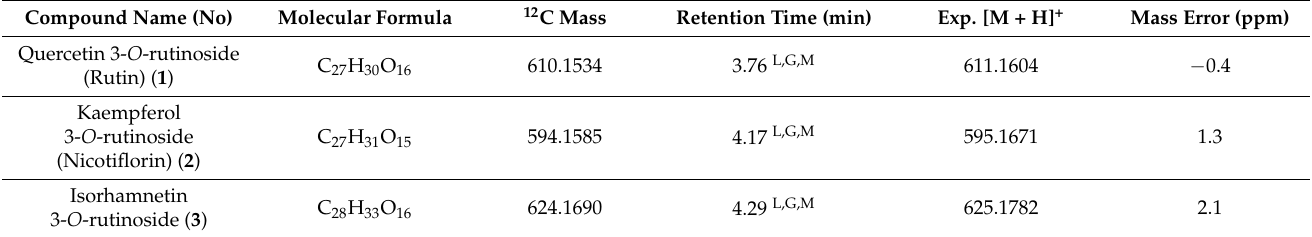
Table 1. Flavonol Glycosides Identified in M. balsamina using RP-LC-TWIMS-HRMS.